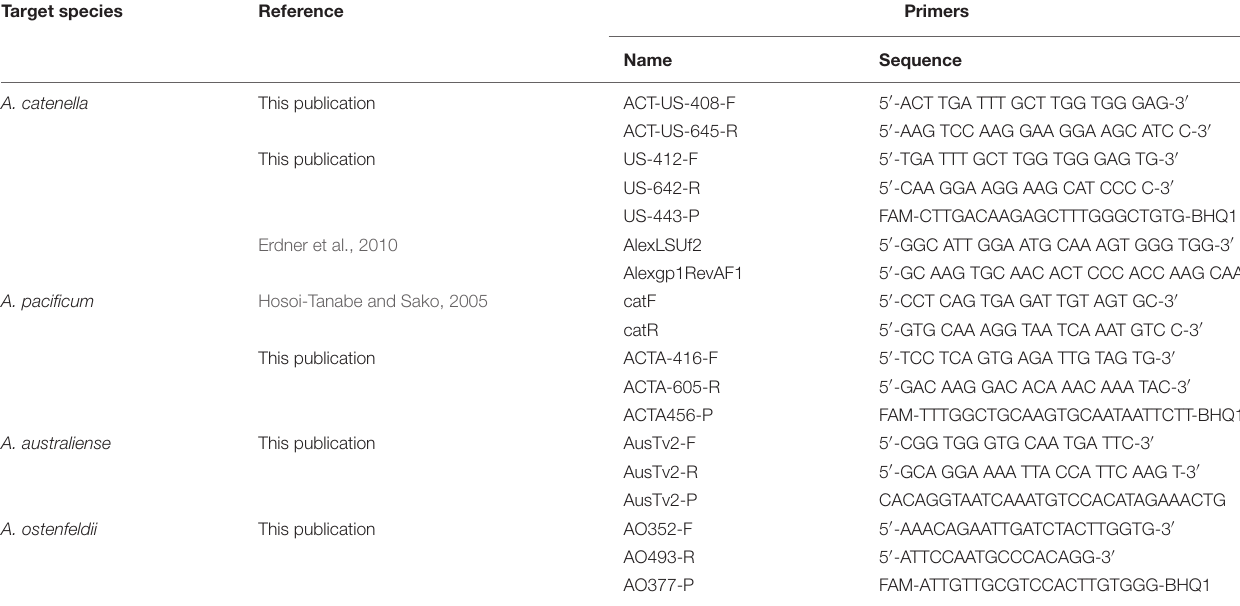
TABLE 2 | Sequence of primers and probes specific to A. catenella , A. pacificum , A. australiense , and A. ostenfeldii . Target species